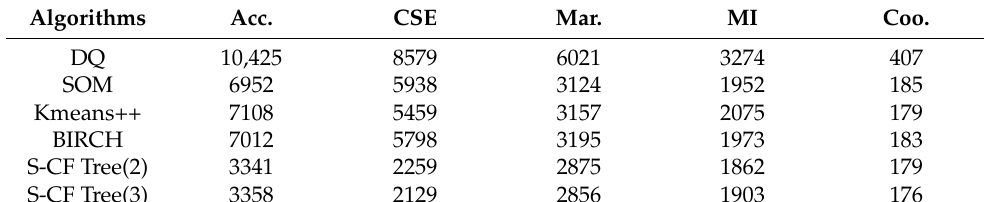
Table 3. Accuracy tests without feature selection.